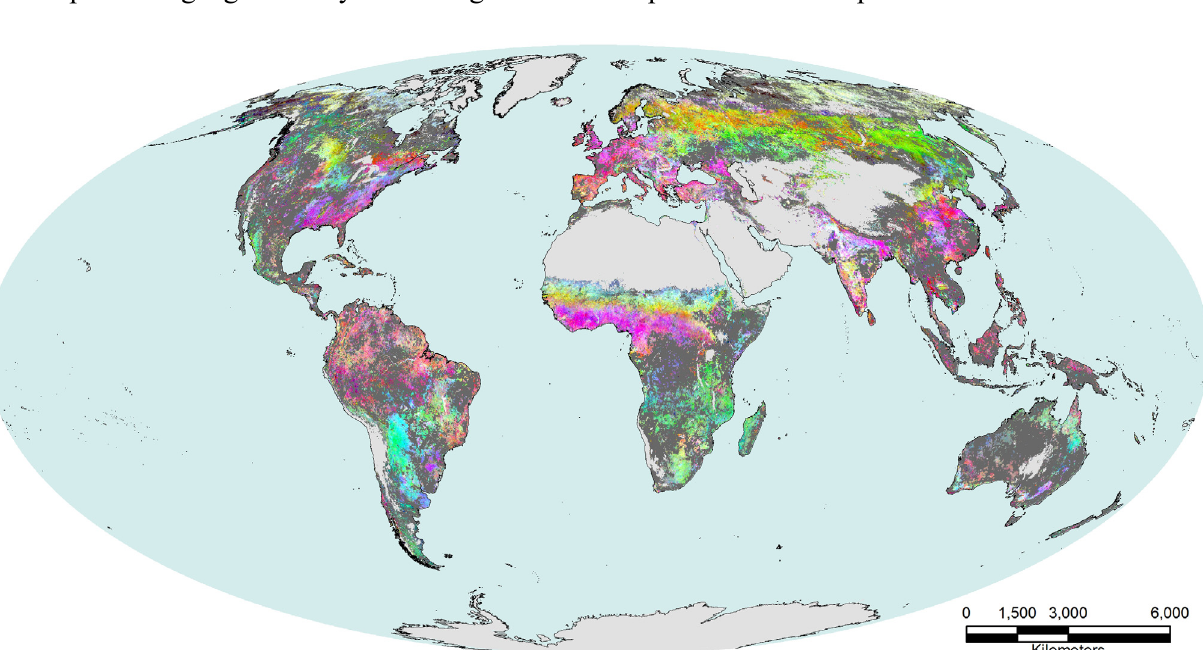
Figure 1. Global mapping of seasonal trends in Normalized Difference Vegetation Index (NDVI), 1982–2011. This color composite expresses trends in Amplitude 0 (mean annual NDVI) in red, trends in Amplitude 1 (annual cycle) in green and trends in Amplitude 2 (semi-annual cycle) in blue. Areas in light gray have been masked because their mean NDVI is less than 0.15. Areas in dark gray have no significant trend. All other colored areas on land characterize trends that are significant at the p < 0.01 level for one or more of the Seasonal Trend Analysis (STA) shape parameters using the Contextual Mann Kendall (CMK) test of trend significance. Thus areas that are bright magenta, for example, are experiencing significantly increasing trends in Amplitude 0 and Amplitude